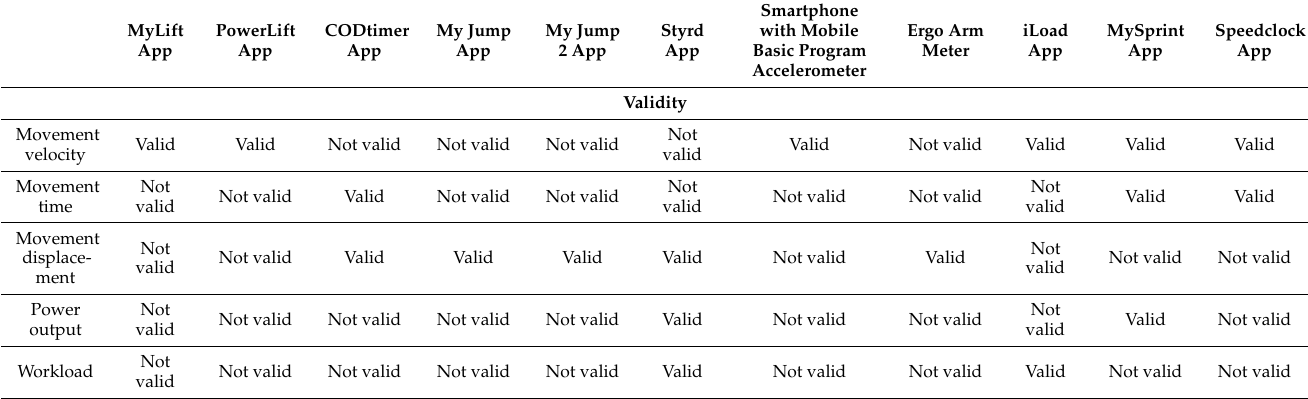
Table 6. Summary of validity of different